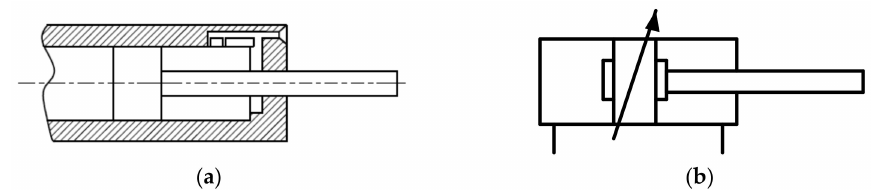
Figure 6. Scheme of an actuator using the orifice method: ( a ) working principles; ( b ) hydraulic symbol.